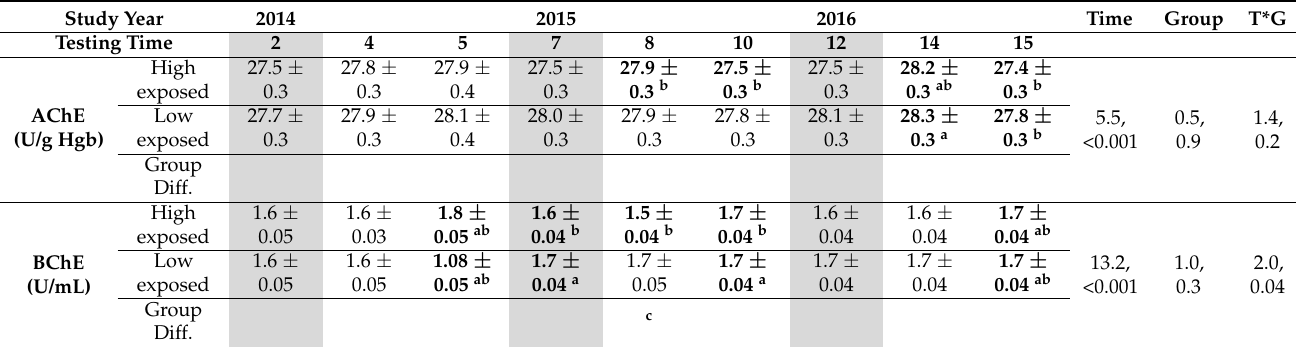
Table 3. Cholinesterase activity (least squares mean ± SE) across the 3 years of study and the relationship with the covari- ates of time, group, and the interaction of time and group. For BChE, age was a significant covariate (f = 5.8, p = 0.02). Cholinesterase activity was assessed at 9 timepoints during the 3-year period. Shaded areas indicate the times of CPF application.